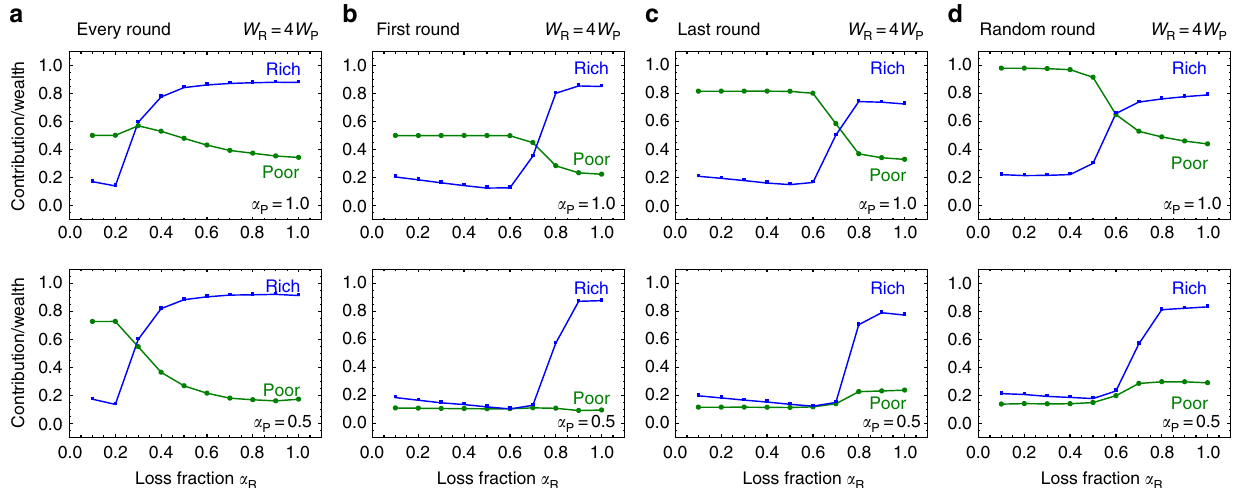
Fig. 3 Variation of lost endowment for rich and poor player. We plot the average contribution from rich and poor players across various α R for the rich player in a four-round game where risk is in a every round, b the fi rst round, c the last or d a random round. Simulations show when poor players lose everything, α P = 1 or half of their wealth α P = 0.5 (games are pair-wise, p C r ½ (cid:3) ¼ 1 þ exp λ C r W 100, 1000 games per generation, mutation rate μ = 0.03, and the standard deviation σ for mutations of the individual decision thresholds τ r is set to 0.15) NATURE COMMUNICATIONS| (2018) 9:2566 |DOI: